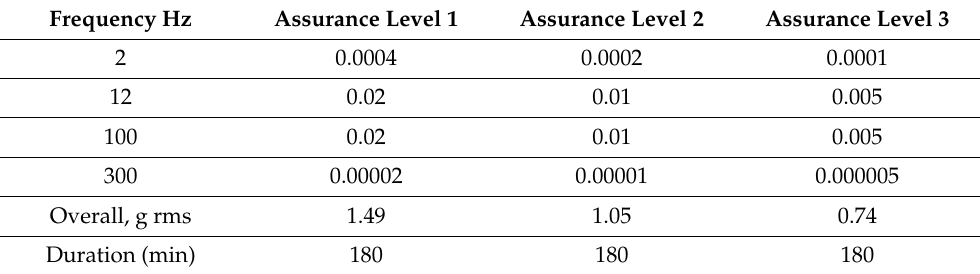
Table 6. The definition of the g acceleration PSD with the frequency range and the amplitudes [22]. Frequency Hz